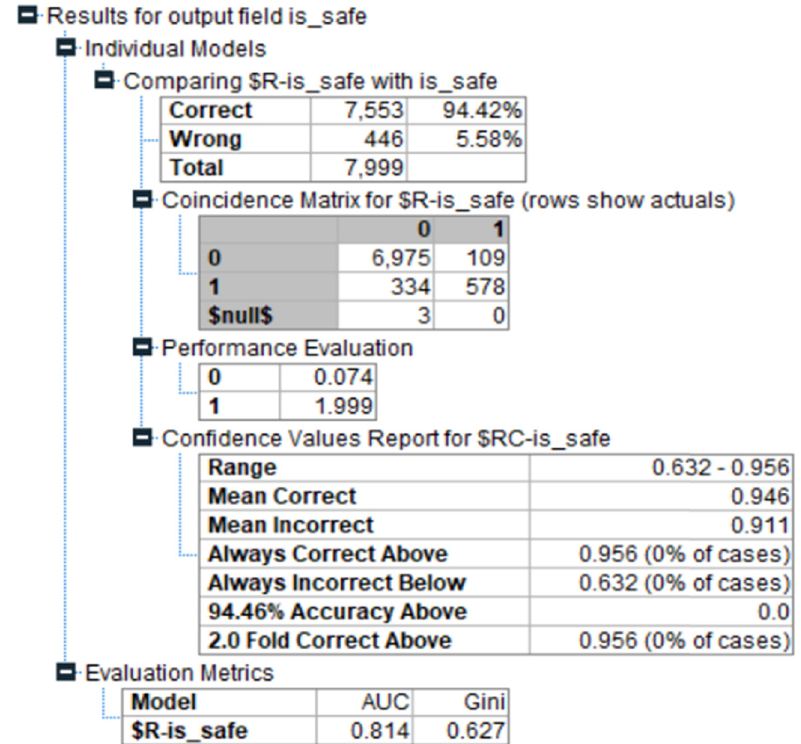
Figure 6: XGBoost tree